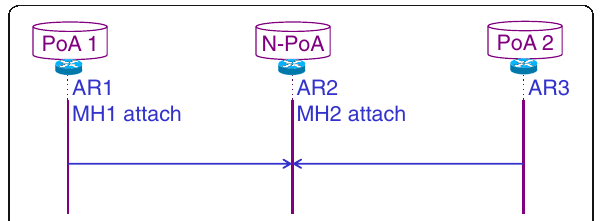
Fig. 8 Many MHs attach at the same time to the same N-PoA but coming from different PoAs using DMHP